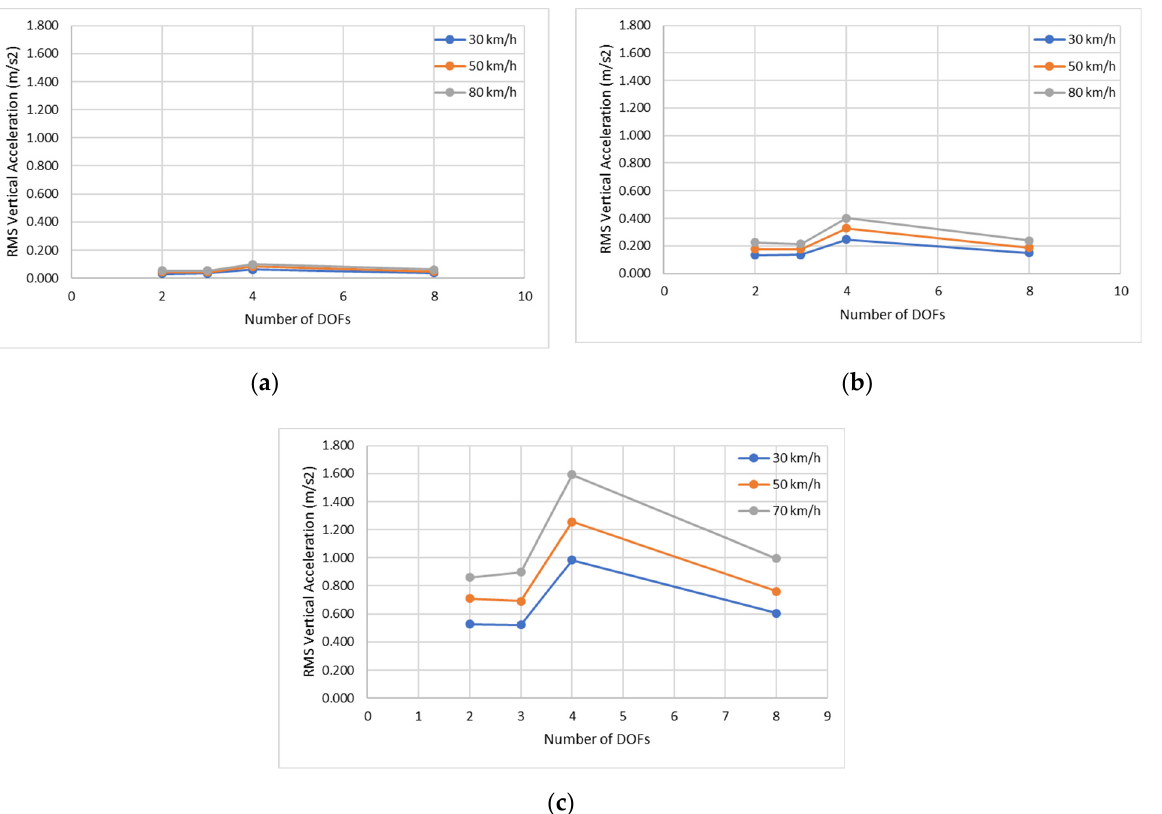
Figure 13. The RMS value of the acceleration of the top DOF for the road profile of Class ( a ) A, ( b ) C and ( c ) E.